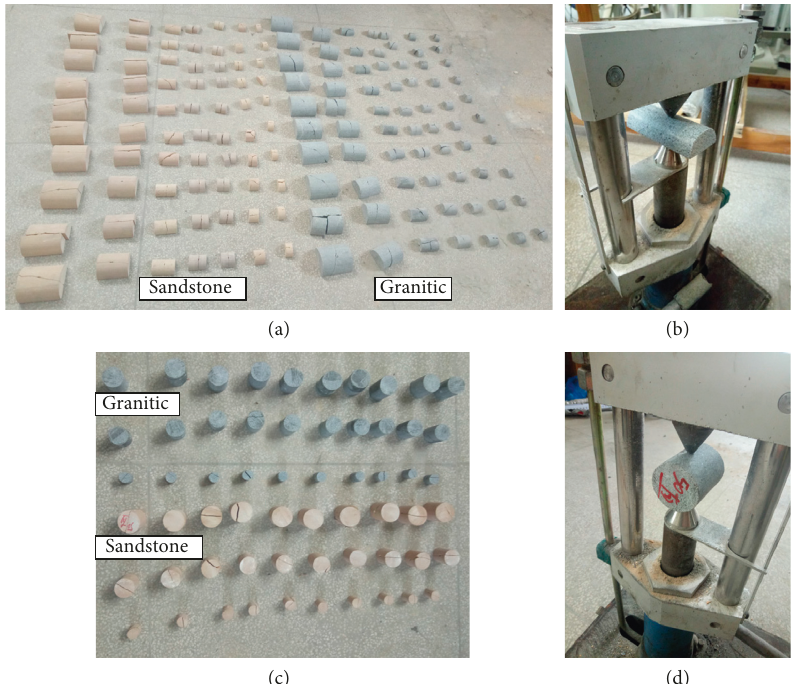
Figure 11: Laboratory point load tests: (a) the half-cylinder specimens, (b) PLTof the half-cylinder specimens, (c) the cylinder specimens, and (d) PLT of the cylinder specimens.